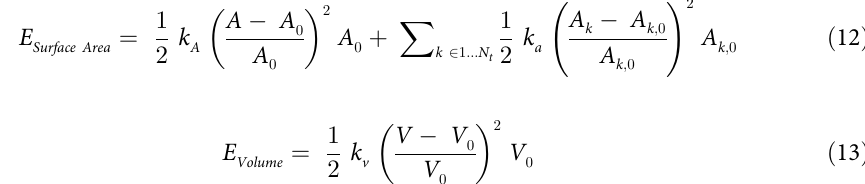
and n are the T 1 T 2